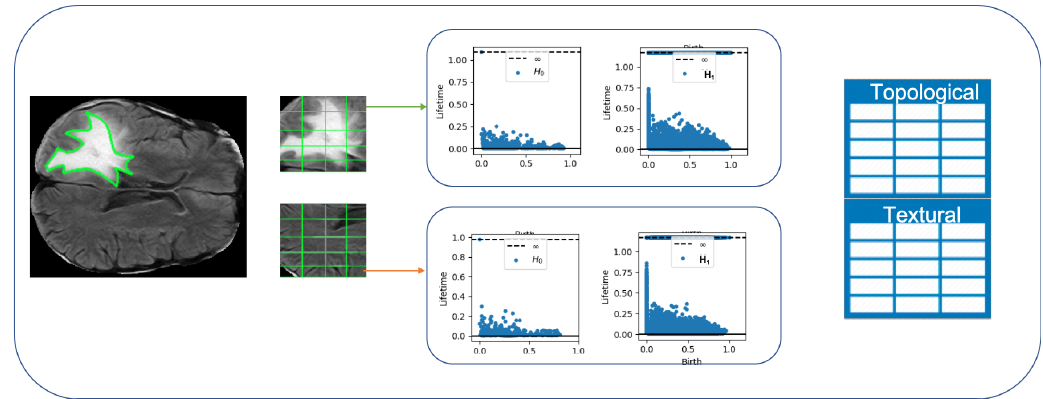
Figure 7. Pictorial representation of the methodology for GBM classification. From left to right : 2D FLAIR slices with region of interest (ROI) surrounding Glioblastoma multiforme (GBM) lesion. Lateral and controlateral ROIs divided in rectangular patches shaping a grid on both of them. Example of Persistent Barcodes for H0 (connected component) and H1 (2D topological loops). Table containing both topological and textural features used for subsequent